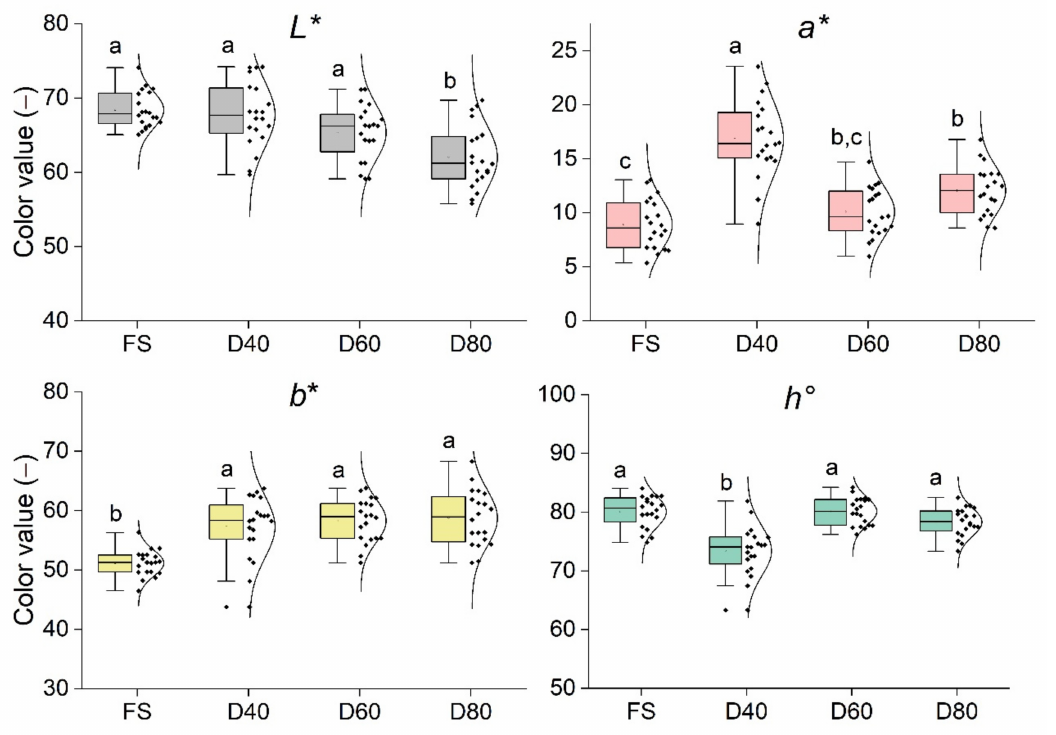
Figure 4. Color values: ( L* ) lightness, ( a* ) green-red, and ( b* ) blue-yellow as well as ( h ◦ ) hue angle of fresh and dried mango slices. FS = fresh samples and D = dried samples at temperatures of 40 ◦ C, 60 ◦ C and 80 ◦ C. Different letters in a graph indicate significant differences at p < 0.05, ( n =